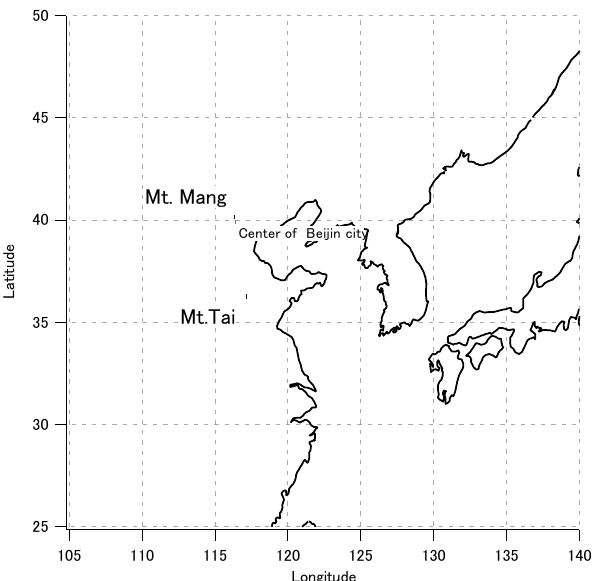
Fig. 1. Map of eastern Asia with sampling sites of Mt. Tai and Mt. Figure 1. Map of eastern Asia with sampling sites of Mt. Tai and Mt. Mang in China. 3 Mang in China.